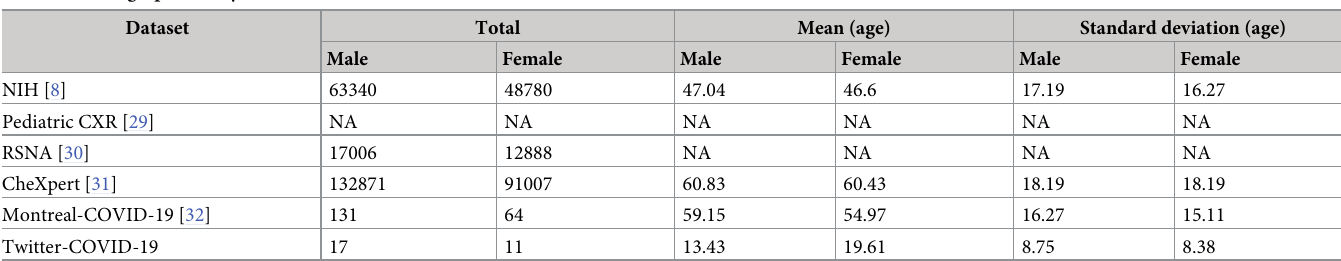
Table 1. Demographic